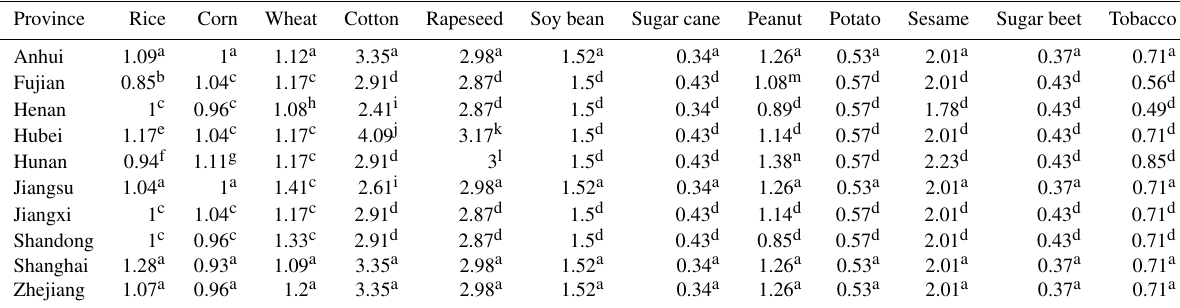
Table 3. Detailed crop residue to production ratio data for each